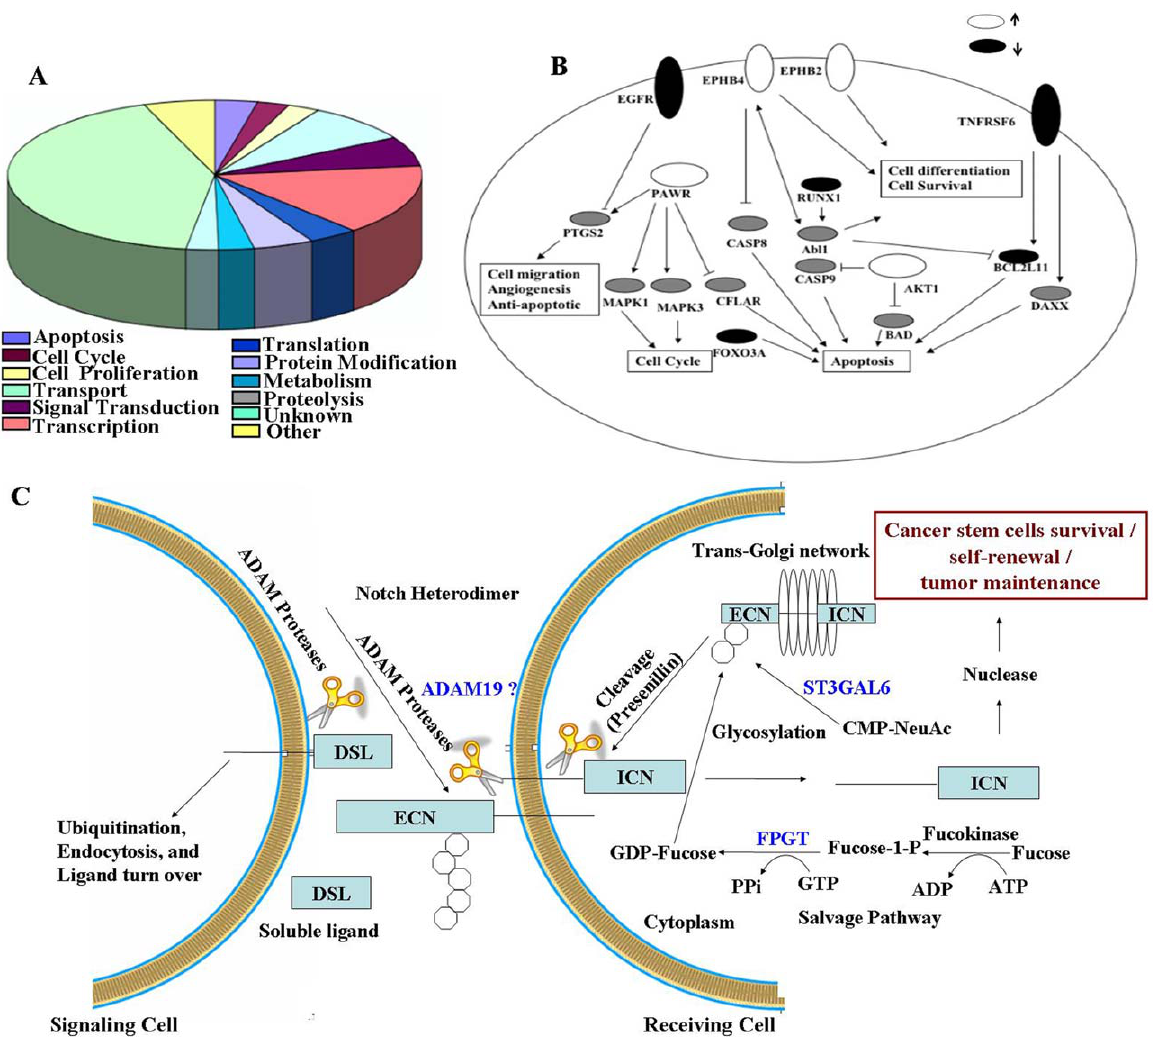
Figure 2. Identification of putative signaling events contributing to ovarian cancer SP cell survival, self-renewal and tumor maintenance. (A) Gene ontology analysis of microarray data (P value , 0.01): The pie diagram shows the biological functions of the differentially expressed genes among SP and MP cells. The gene signature was enriched for genes in gene ontology biological processes of apoptosis, cell cycle, cell proliferation, transport, signal transduction, transcription, translation, protein modification, metabolism and proteolysis. Other represents genes involved in defense response, vasculogenesis, blood coagulation, visual perception, ontogenesis, cell matrix adhesion, and initiation of primordial ovarian follicle growth. (B) Graphical representation of the literature derived facts about the biological pathways involved in SP cells. Pathway Studio 6.0 software was used to identify the activated pathways in SP cells. Solid symbols representing the genes (EGFR, TNFRSF6, BCL2L11, FOXO3A, RUNX1) as down regulated in SP cells, the open symbols represents the upregulated genes (EPHB4, EPHB2, PAWR, AKT1) and gray symbols are the genes whose expression did not change significantly between SP and MP cells. (C) The Notch signaling pathway: The figure shows the schematic of Notch signal transduction elements. The overexpressed proteins in SP cells (FPTG, ST3GAL6 and ADAM19) are shown in blue color. Post-translational modification of precursor Notch-protein includes cleavage by proteases and glycosylations in the trans-Golgi. Adherence of Notch extracellular domain (ECN) with Notch intracellular domain (ICN) results in mature Notch heterodimers and they are transferred to the cell membrane. Receptor interaction with the ligands of the DSL family (Delta, Serrate, Lag3) on neighboring cells is modulated by glycosylations of ECN. Successful interaction of extracellular ligand regions with EGF-like repeats of ECN lead to the proteolytic cleavages of Notch transmembrane domain by two sequential steps by ADAM proteases and presenilins with c –secretase activity. The released Notch intracellular domain is translocated to the nuclease where it interacts with CSL1, replacing CSL repressors and forming a transcription complex with Mastermind-like factors and transcriptional coactivators. This transcriptional complex activates downstream target genes and may account for cancer stem cell survival, self-renewal and tumor maintenance in